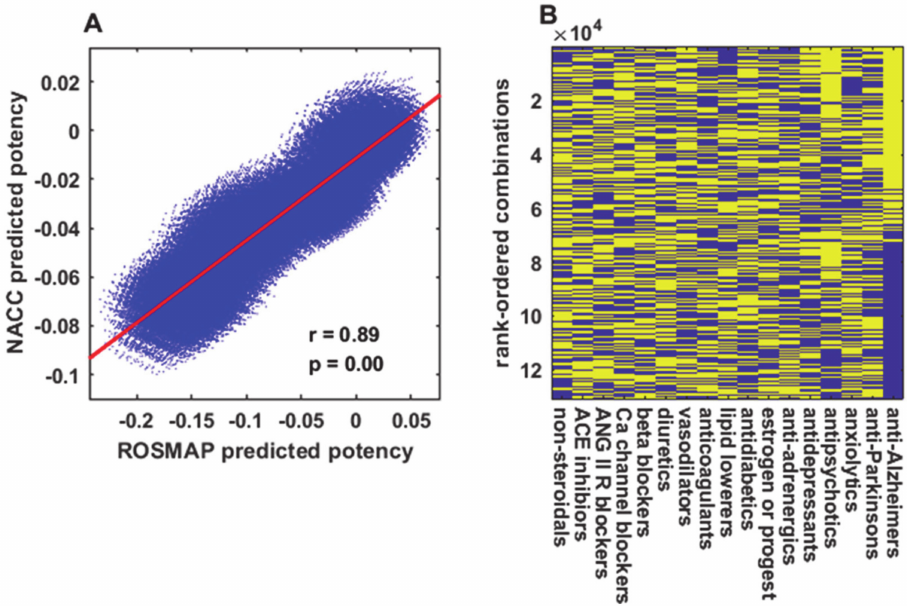
Figure 3. Predicting potent drug combinations jointly from ANNs trained separately on the ROSMAP or NACC datasets for the 131,072 combinations of 17 drug categories. ( A ) The potencies predicted by ANNs trained on the ROSMAP and NACC datasets are highly statistically significantly correlated. Each blue dot represents one drug combination, located by its ROSMAP and NACC predicted potency (r is the correlation coefficient, and p is the probability that the correlation occurred by chance). ( B ) All 131,072 drug combinations are ranked according to predicted potency (top is highest) and displayed as a heat map (yellow, drug present; blue, drug absent). Each column represents one of the 17 drug categories. The most potent drug combinations include anti-Alzheimer’s drugs (shown in the last